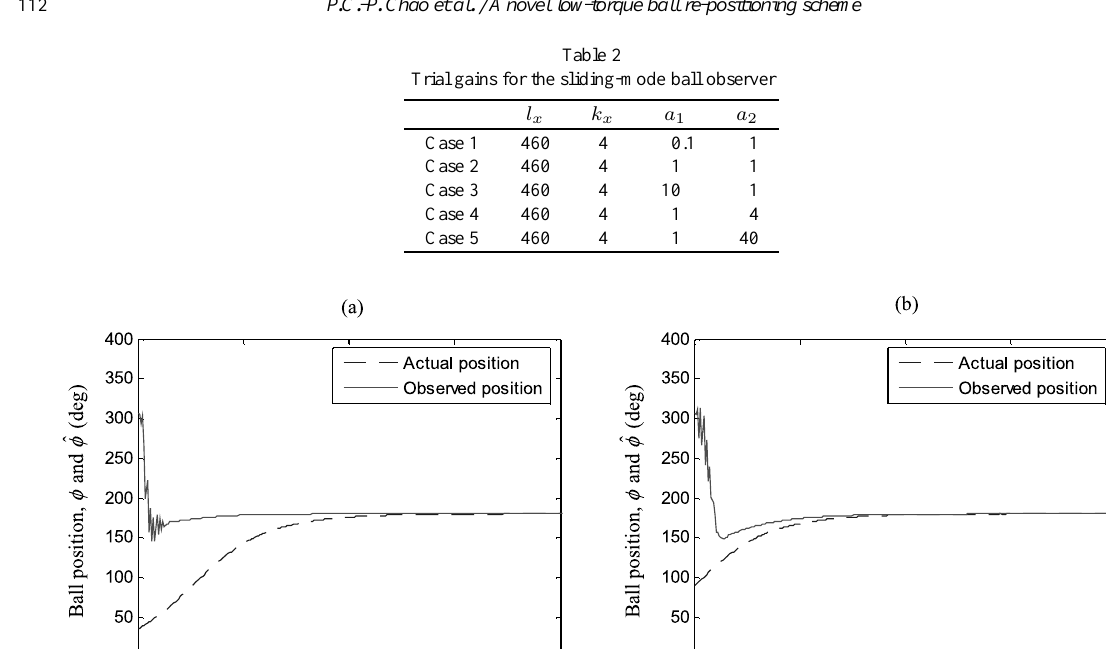
Table 2 Trial gains for the sliding-mode ball observer